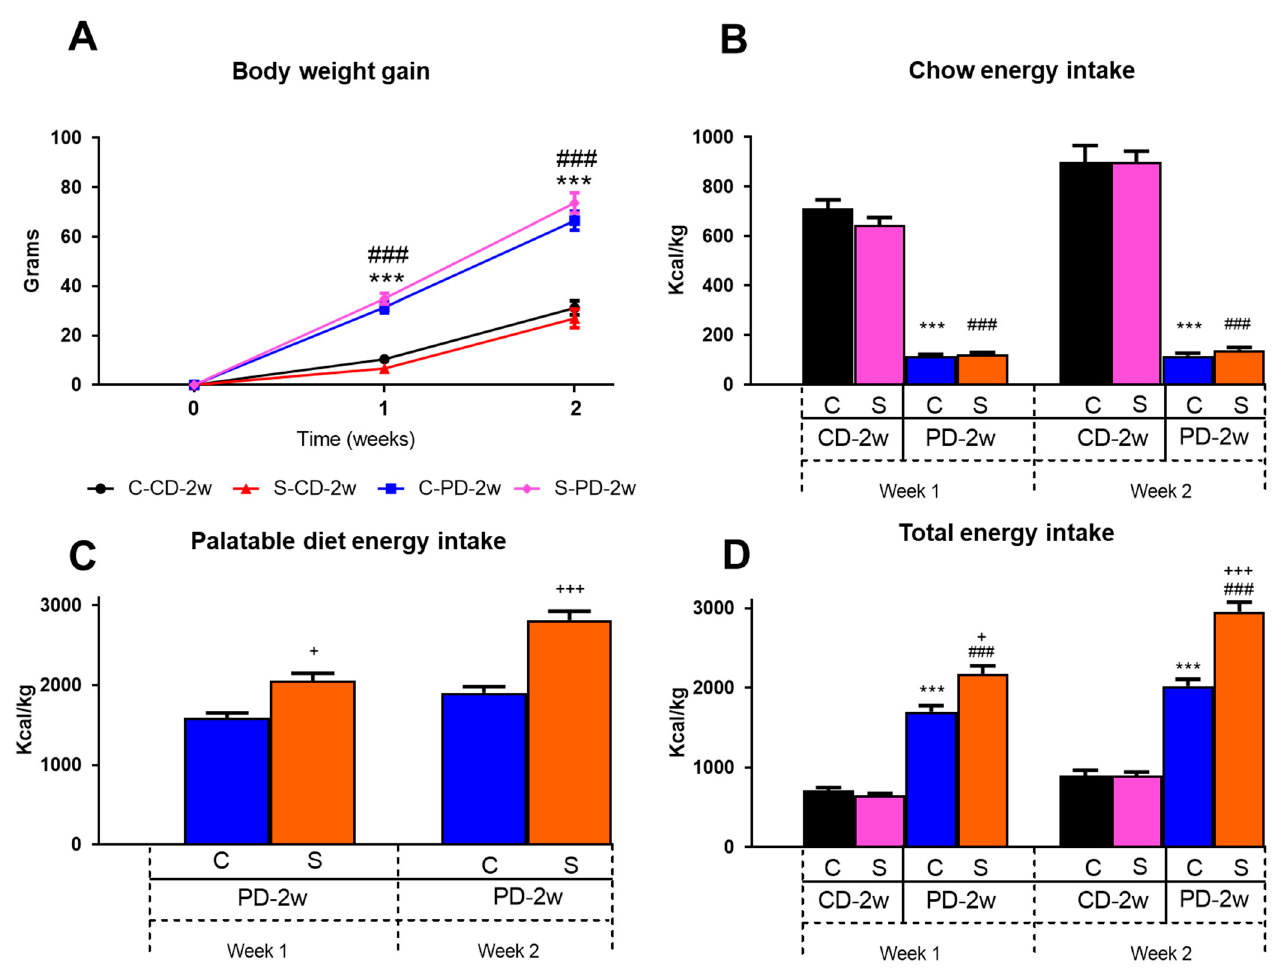
Figure 2. Effect of stress and a palatable diet on body weight and energy intake. ( A ) Body weight (b.w.) gain of the control (C) or stressed (S) rats fed a regular chow diet (CD) or palatable diet (PD, chocolate milk ingestion) for 2 weeks (C-CD-2w, S-CD-2w, C-PD-2w, and S-PD-2w), n = 6 rats/group in C-CD-2w and S-CD-2w; n = 20 rats/group in C-PD-2w and S-PD-2w. ( B ) Chow energy intake, ( C )